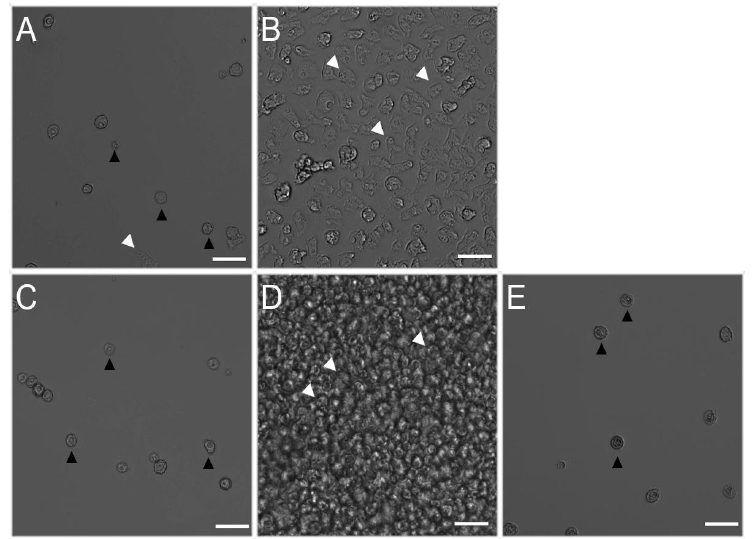
Figure 4. Effect of combination of isavuconazonium sulfate and PHMB on the morphology of Acanthamoeba Ma cysts. Ma cysts were treated with ( A ) 20.52 μ M thamoeba Ma cysts. Ma cysts were treated with ( A ) 20.52 µ M isavuconazonium and 40.41 µ M PHMB, isavuconazonium and 40.41 μ M PHMB, ( B ) 20.52 μ M isavuconazonium monotherapy, ( C ) ( B ) 20.52 µ M isavuconazonium monotherapy, ( C ) 40.41 µ M PHMB monotherapy, ( D ) 0.5% ( v / v ) 40.41 μ M PHMB monotherapy, ( D ) 0.5% ( v / v ) DMSO, ( E ) 461.85 μ M PHMB. Morphology and excystation of Acanthamoeba cysts were evaluated after 7 days of incubation in PYG DMSO, ( E ) 461.85 µ M PHMB. Morphology and excystation of Acanthamoeba cysts were evaluated growth media. Black arrowheads: cysts. White arrowheads: trophozoites. Magnification: after 7 days of incubation in PYG growth media. Black arrowheads: cysts. White arrowheads: 200×. Scale bar: 50 μ m. trophozoites. Magnification: 200 × . Scale bar: 50 µ